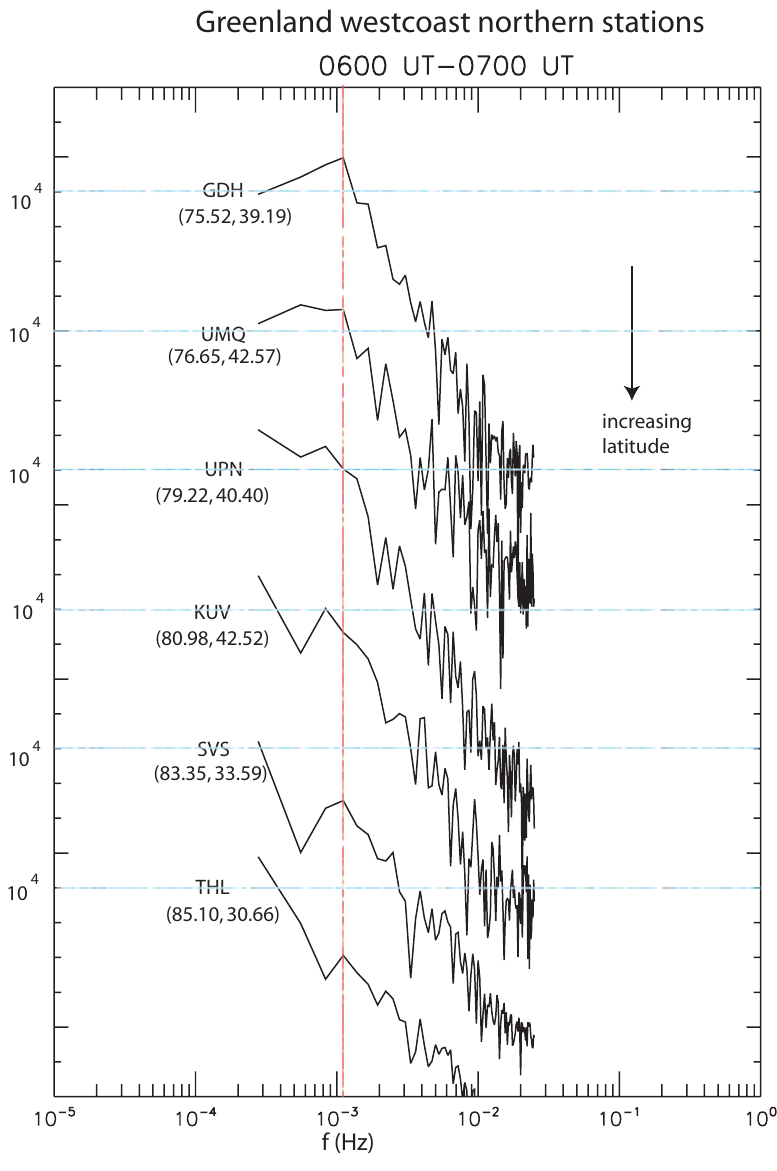
Fig. 9. (a) The power spectra for the northern stations and (b) the power spectra for the southern stations in Greenland’s west coast in the order of increasing